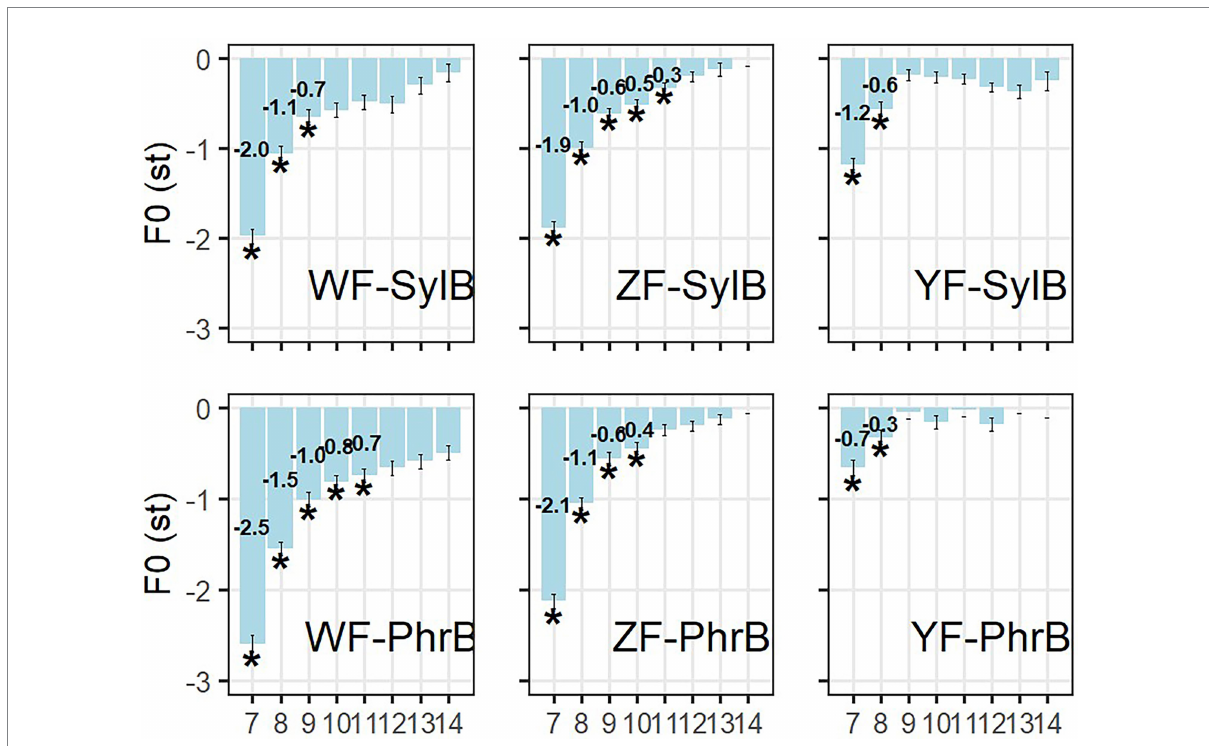
FIGURE 6 The downstep size in the Wide-focus (WF), Z-focus(ZF), and Y-focus (YF) conditions, divided by syllable (SylB) and phrase boundary (PhrB) conditions. The significant downstep effects are marked with * indicating that p < 0.05. The x -axis shows syllable numbers, in which the 7th is syllable Y, the H tone right after the L tone.